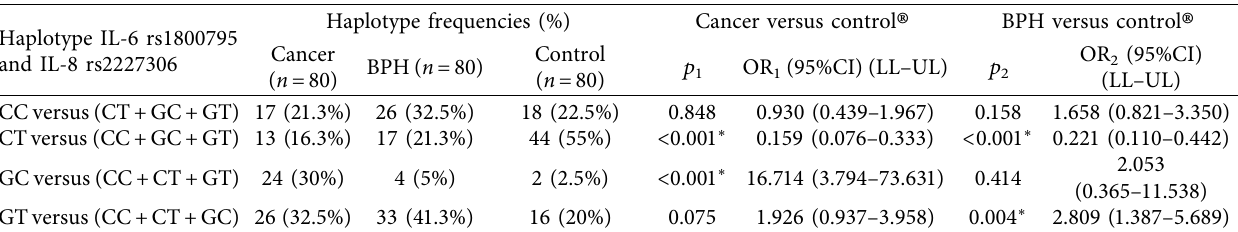
Table 5: Comparison of haplotype frequencies of IL-6 rs1800795 and IL-8 rs2227306 SNPs in the affected and the control groups. Haplotype IL-6 rs1800795